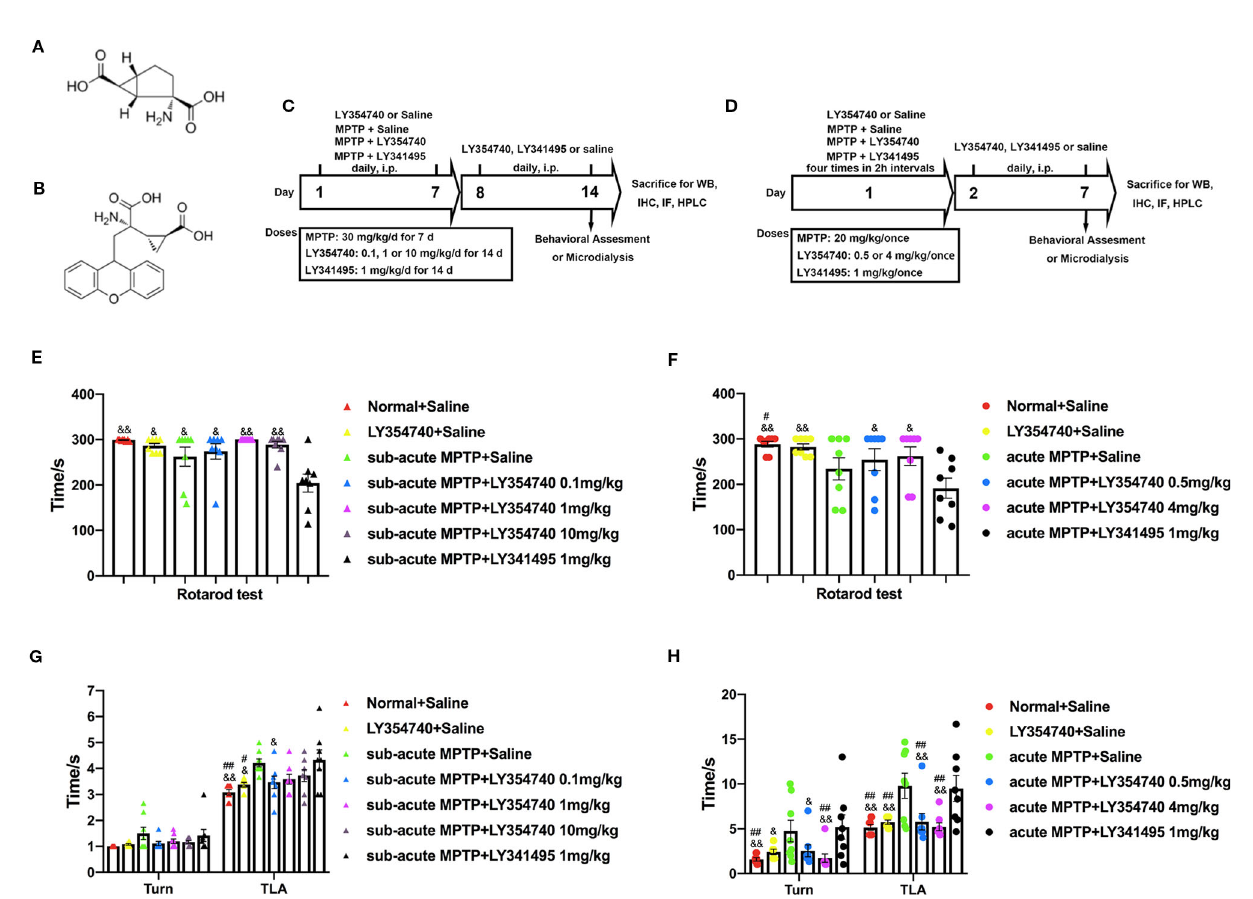
FIGURE 1 | Experimental designs and the effect of chronic treatment with ligands of mGlu 2/3 receptors on locomotor functions in acute or sub-acute 1-methyl-4- phenyl-1,2,3,6-tetrahydropyridine (MPTP)-induced Parkinson ’ s disease (PD) mice models. (A) Molecular formula of LY354740. (B) Molecular formula of LY341495. (C) Schematic representation of the sub-acute MPTP-induced PD mice model experimental scheme. (D) Experimental design of acute-MPTP induced PD mice models. Representative analysis of rotarod tests (E) and pole tests (G) in sub-acute MPTP mice models. Behavioral tests were performed 30 min after the last treatment of drug intervention in sub-acute MPTP mice models on the fourteenth day. # p < 0.05, ## p < 0.01 compared with the MPTP + saline group; & p < 0.05, && p < 0.01 compared with MPTP + LY341495 group. N = 8. Error bars represent SEM. Analysis of rotarod tests (F) and pole tests (H) on the seventh day of the experiment in acute MPTP mice models. Behavioral tests were performed 30 min after the last treatment of drug intervention. # p < 0.05, ## p < 0.01 compared with the MPTP + saline group; & p < 0.05, && p < 0.01 compared with the MPTP + LY341495 group. N = 8. Error bars represent